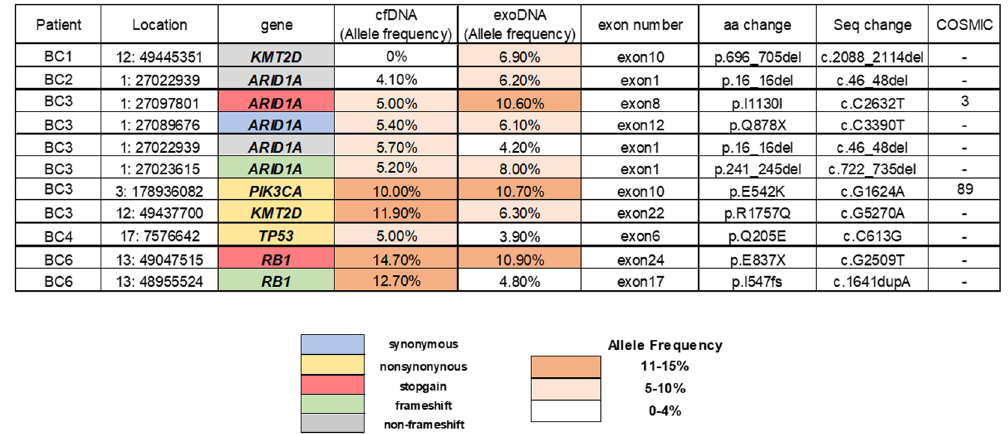
Figure 2. Mutations only identified in urinary cell free DNA and exosomal DNA.